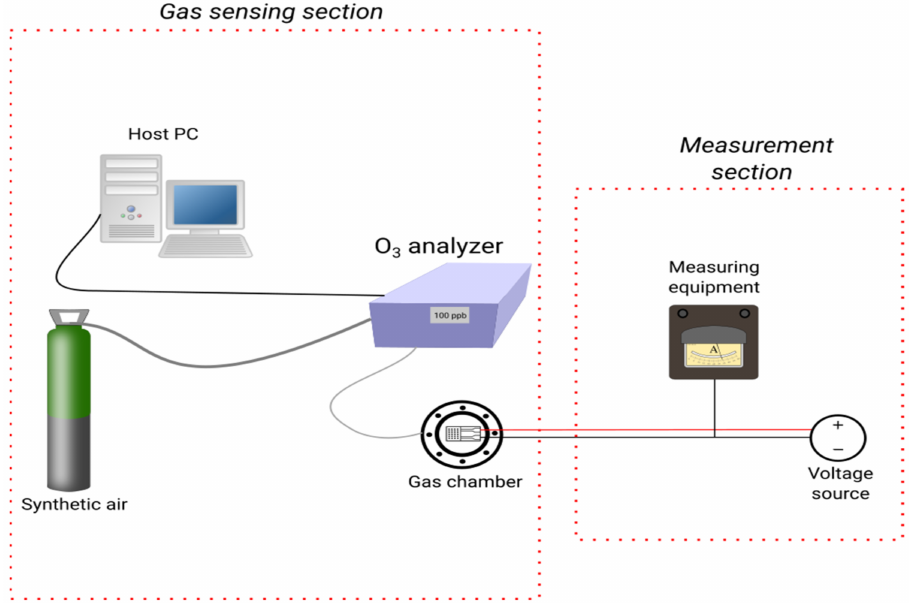
Figure 1. Experimental setup for gas sensing